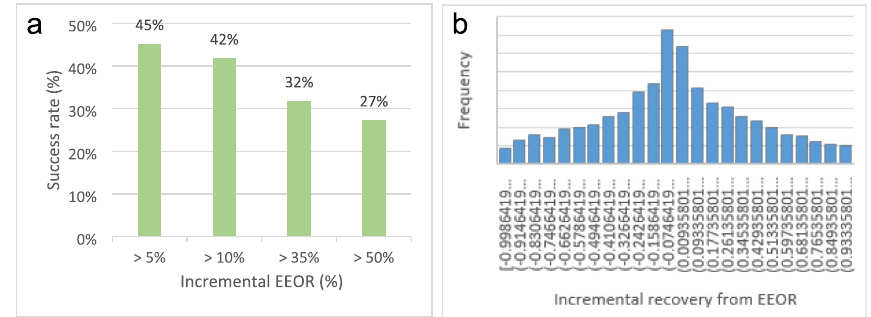
Fig. 6 a Success rates of incremental EEOR. b Variations in incremental recovery from EEOR during